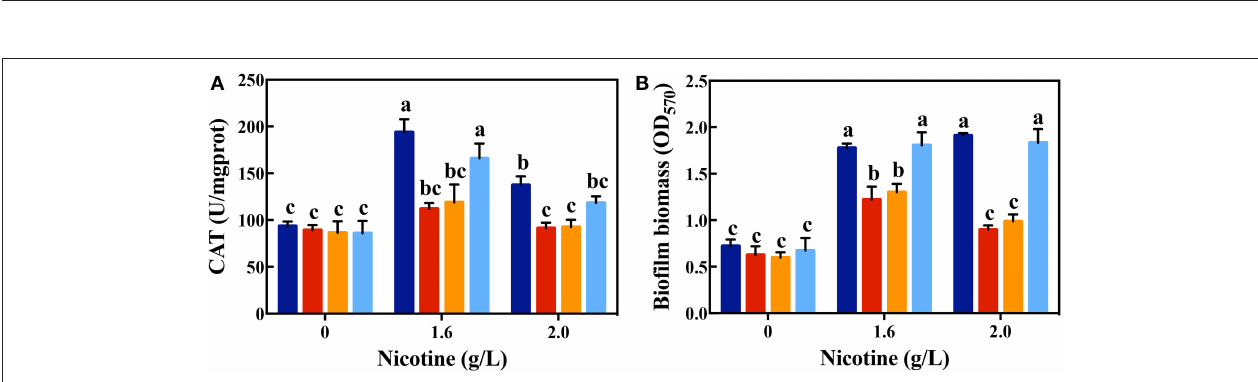
FIGURE 5 | The competition between the WT (blue bars) and 1 lasR (red bars) strains (A) , or between the 1 rhlR (yellows bars) and 1 lasR strains (B) on exposure to different concentrations of nicotine.